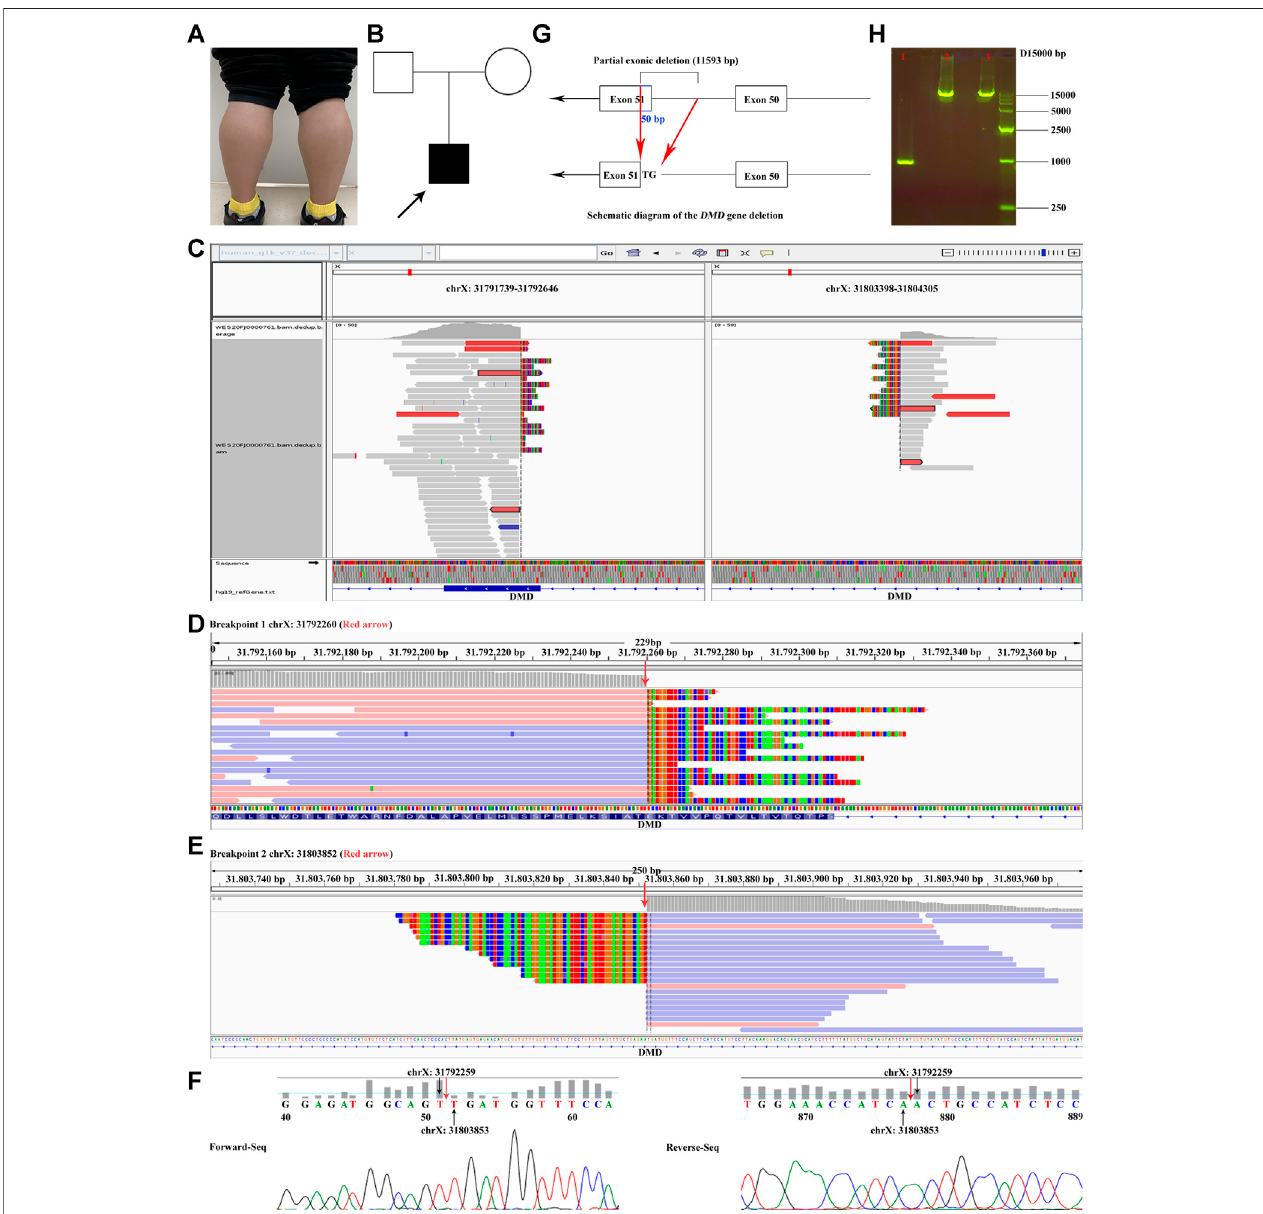
FIGURE 1 | Proband clinical features, breakpoints suggested by WES, and breakpoints validation. (A) Bilateral gastrocnemius hypertrophy of the proband in November 2020. (B) Family tree. (C) The overview of the two breakpoints after analyzing the original BAM fi le of the proband. One breakpoint is in chrX: 31791739 – 31792646;theotherisinchrX:31803398 – 31804305. (D,E) Thetwobreakpoints(redarrow)of DMD suggestedbyCNVandbreakpointanalysisoftheWES data. (F) Validationofthebreakpointsby Sangersequencing.Red arrow represents thepositions ofthe breakpoints. (G) Diagrammaticsketchofthe